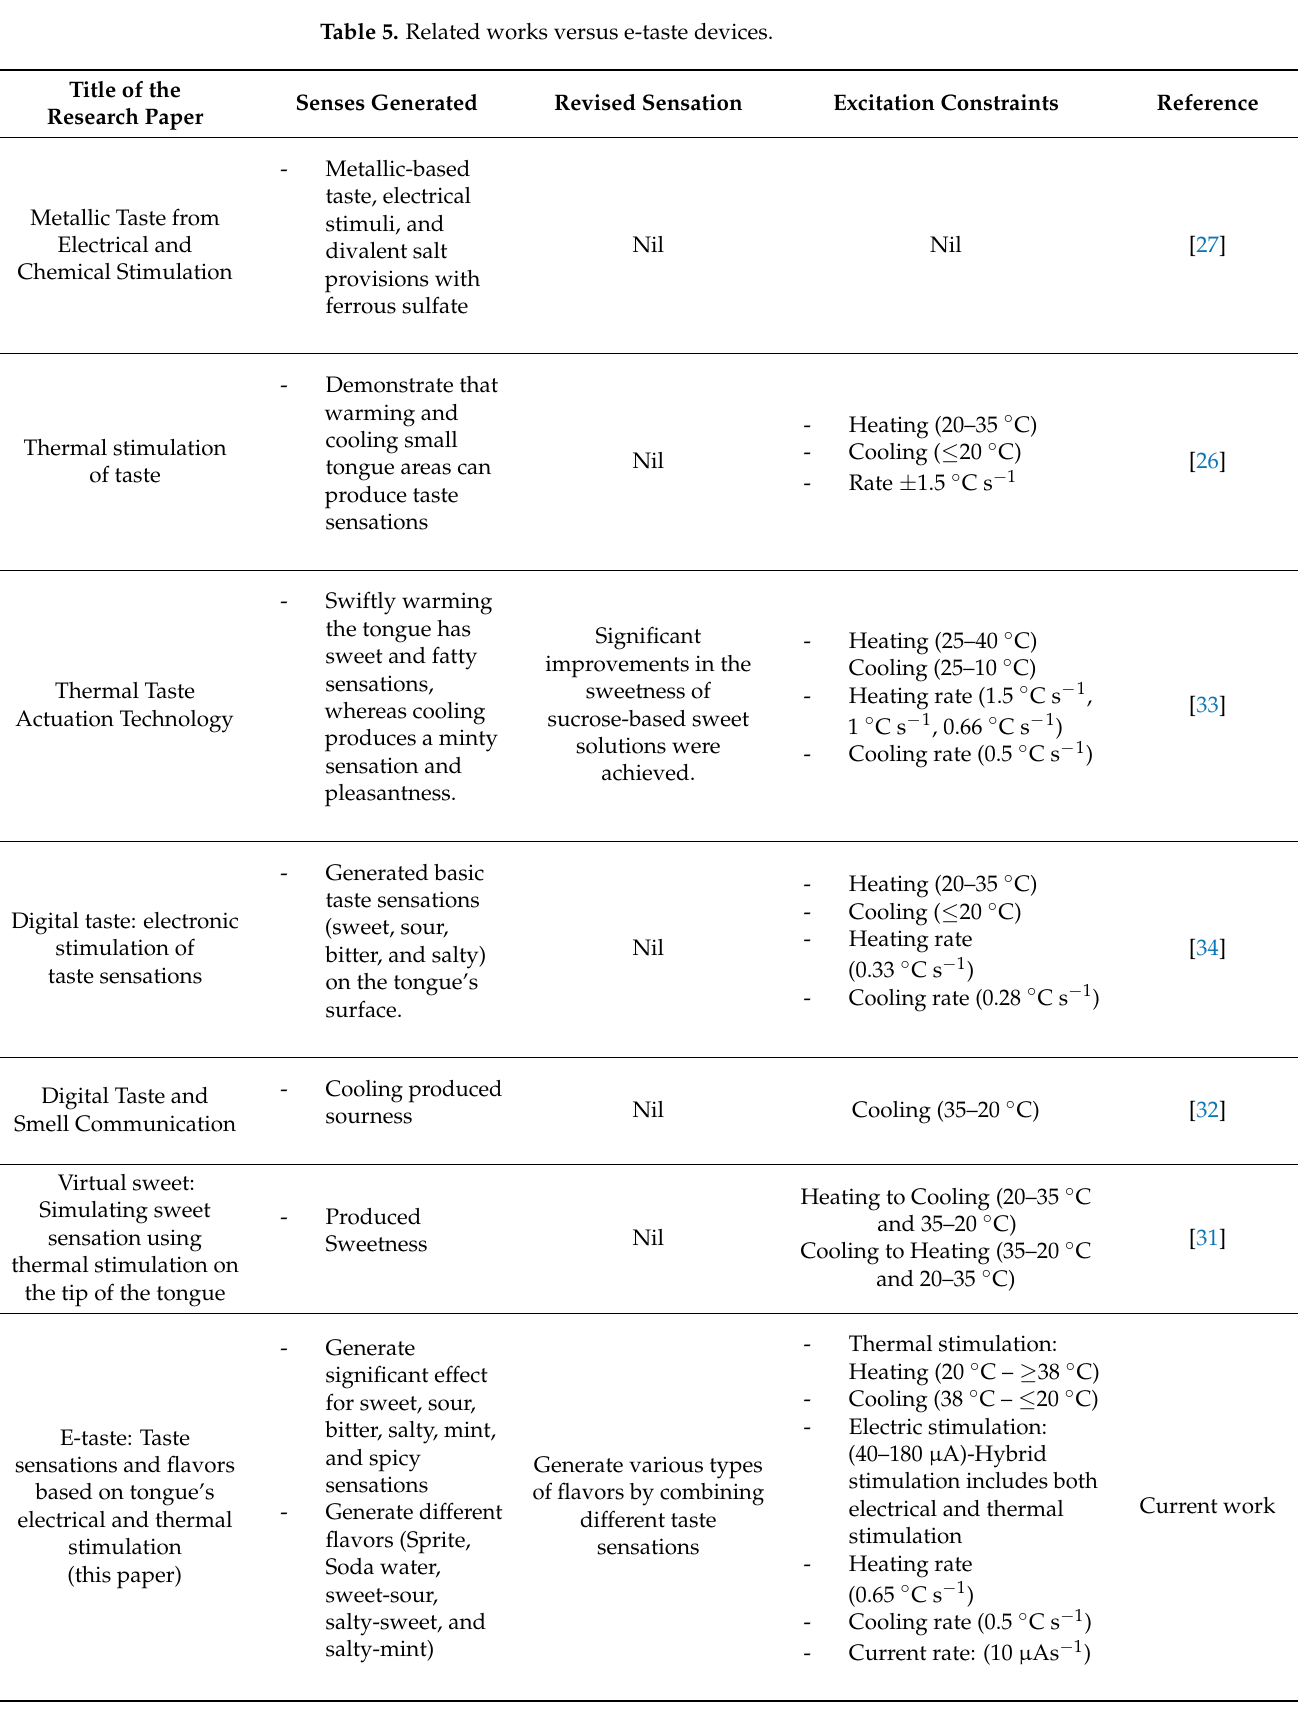
Table 5. Related works versus e-taste